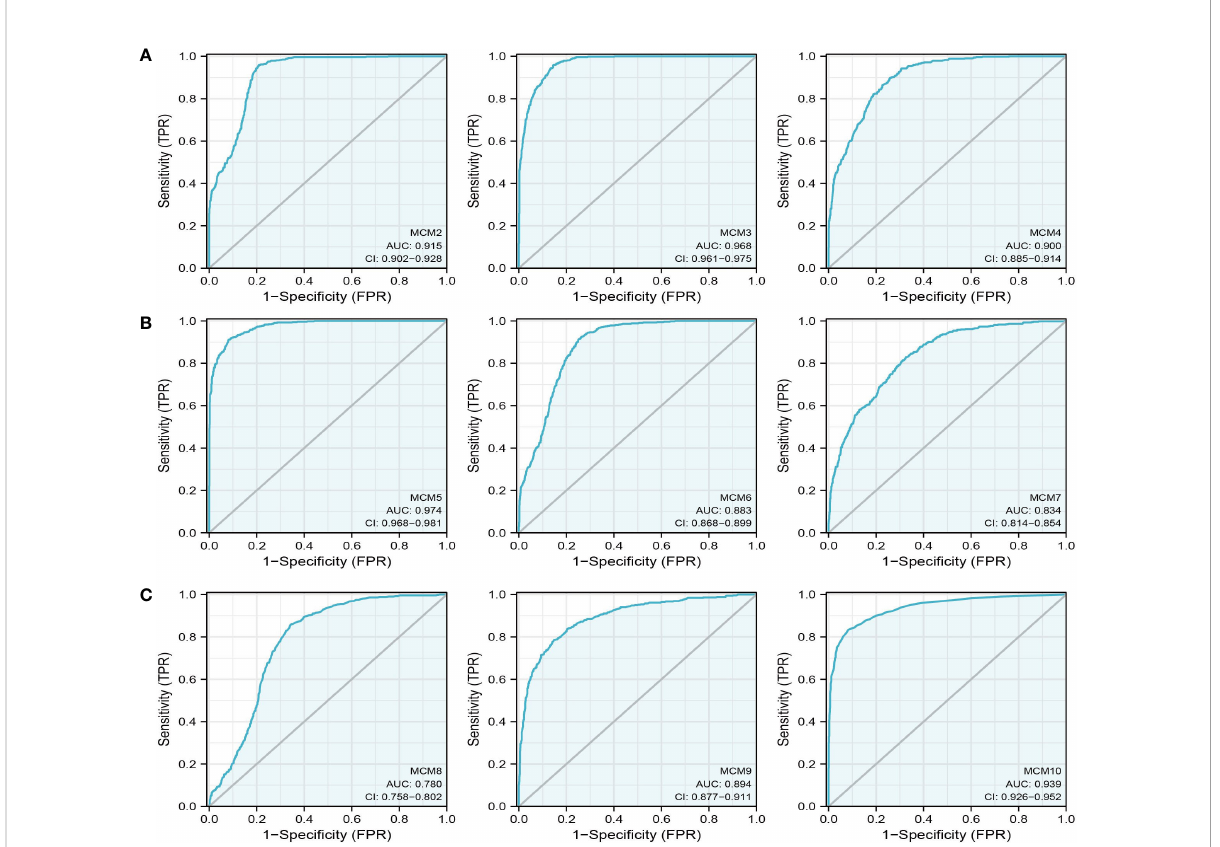
FIGURE 7 The ROC curve of MCMs in glioma. (A – C) The progression-free survival of MCMs in glioma was examined by the TCGA